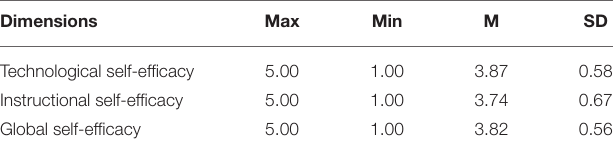
TABLE 5 | Descriptive analysis of the dimensions in T-SE Q.